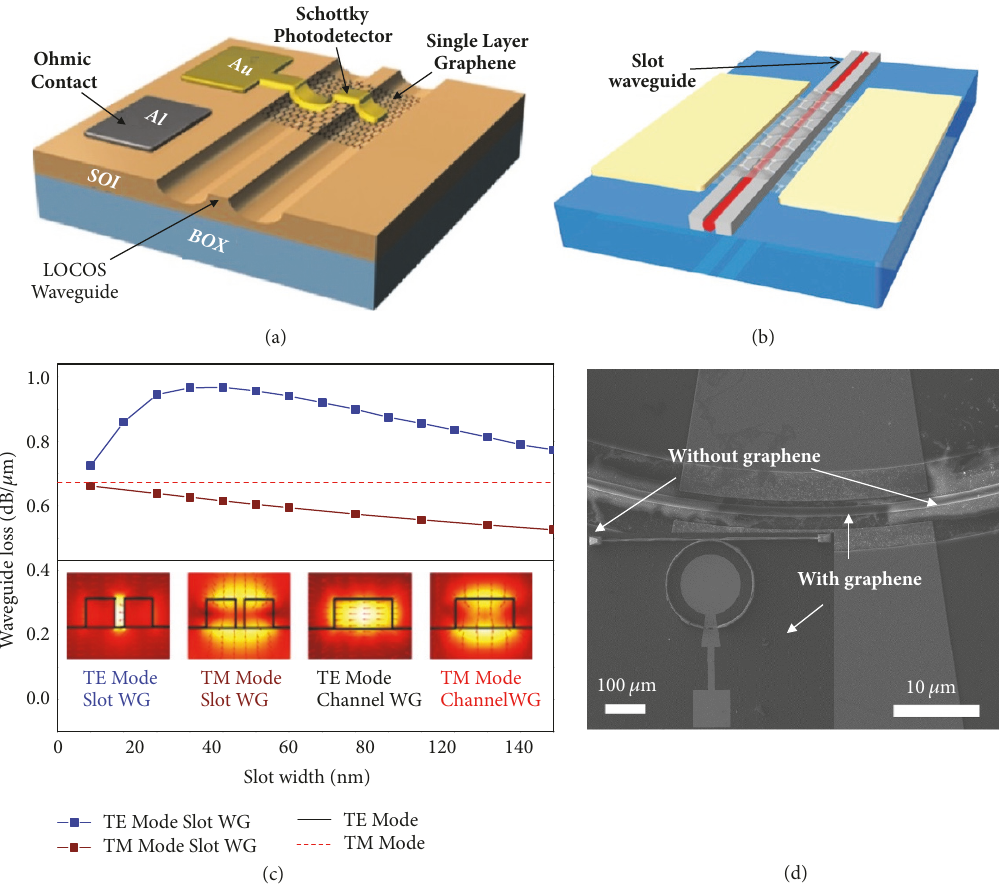
Figure 4: Waveguide-integrated graphene photodetectors. (a) Schematic of the graphene Schottky diode integrated on the SOI waveguide. (b) Schematic of the graphene-on-silicon slot waveguide photodetector. (c) Simulation results of the graphene-on-waveguide absorption coefficients. (d) SEM image of the graphene-on-silicon nitride microring resonator photodetector. (a) is reprinted with permission from [53]. Copyright © 2016 American Chemical Society. (b)-(c) are reprinted with permission from Ref. [54]. Copyright © 2016 Royal Society of Chemistry. (d) is reprinted from [29]. Copyright © 2016 Optical Society of